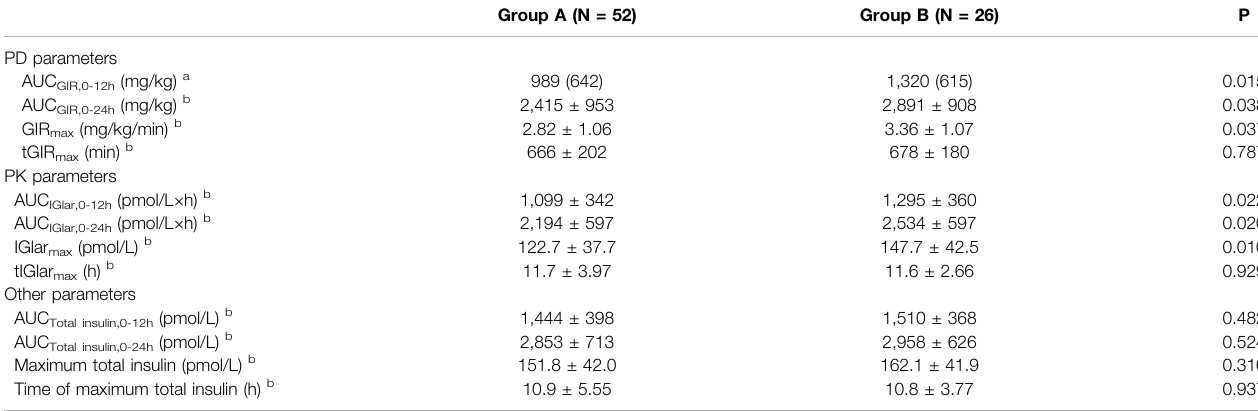
TABLE 3 | The pharmacokinetic and pharmacodynamic parameters in groups A and B.